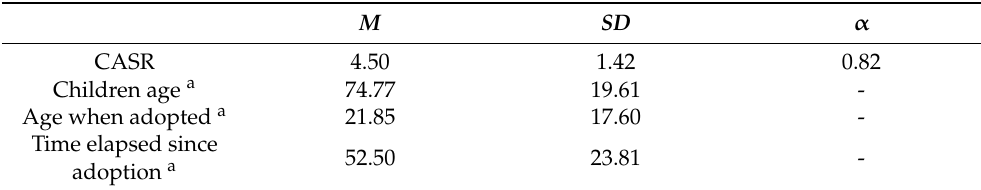
Table 1. Descriptive statistics of children